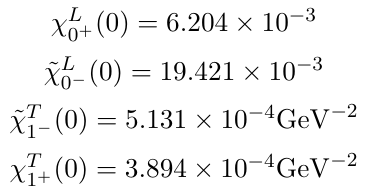
Table 1. Various inputs in our analysis, the (cid:31) ’s are the functions relevant for BGL parametrizations of the form-factors, for detail see [8,